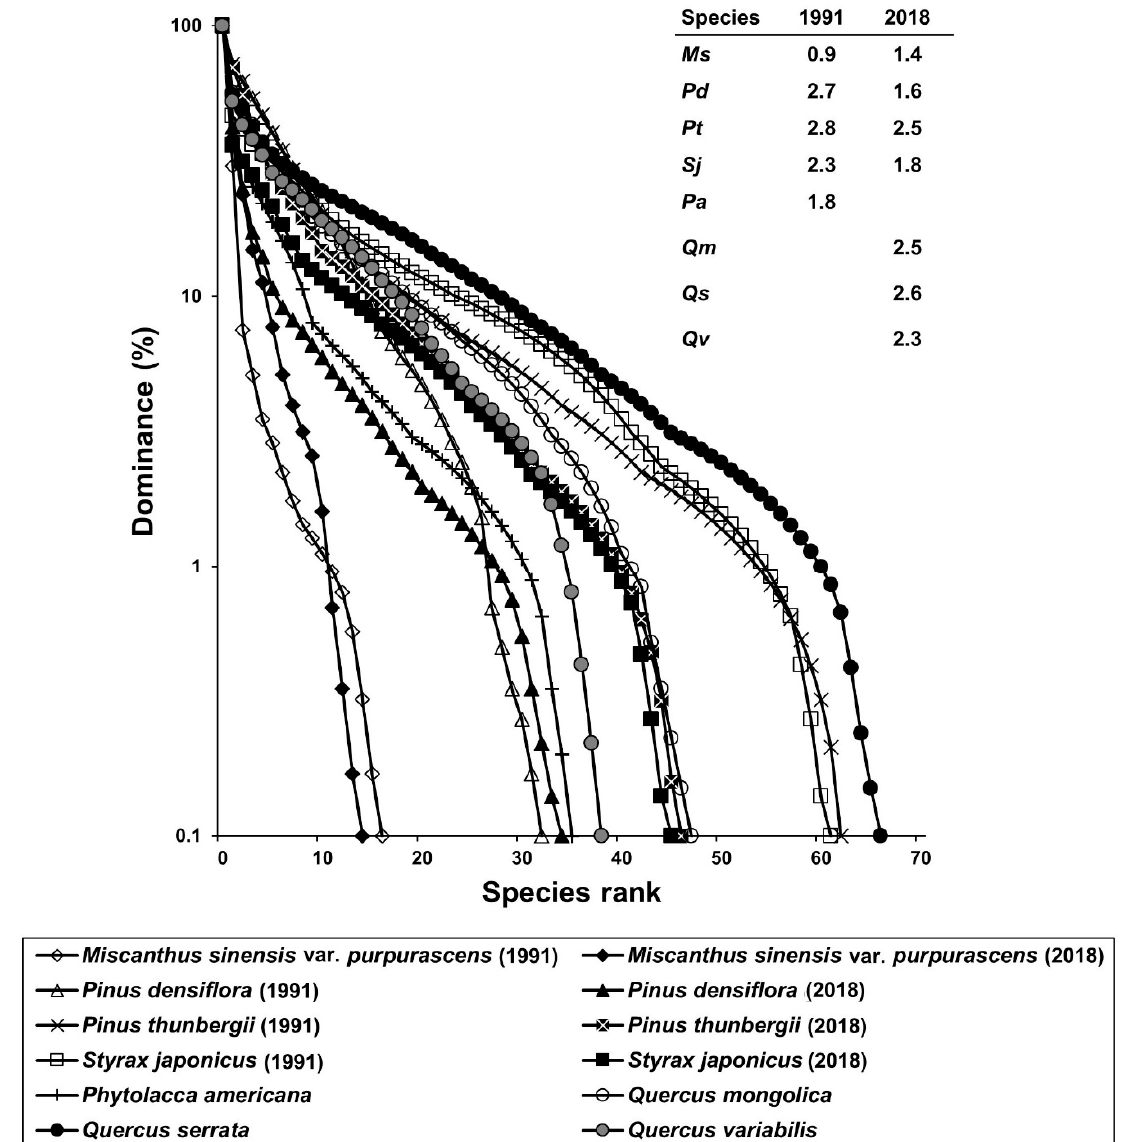
Figure 3. Species rank dominance curves of plant communities established around the Yeocheon industrial complex. 1991 and 2018 indicate the survey years. The numbers in the inset indicate the Shannon indices. Ms: Miscanthus sinensis var. purpurascens stand, Pd: Pinus densiflora stand, Pt: P. thunbergii stand, Sj: Styrax japonicus stand, Pa: P . americana stand, Qm: Quercus mongolica stand, Qs: Q . serrata stand, Qv: Quercus variabilis stand.